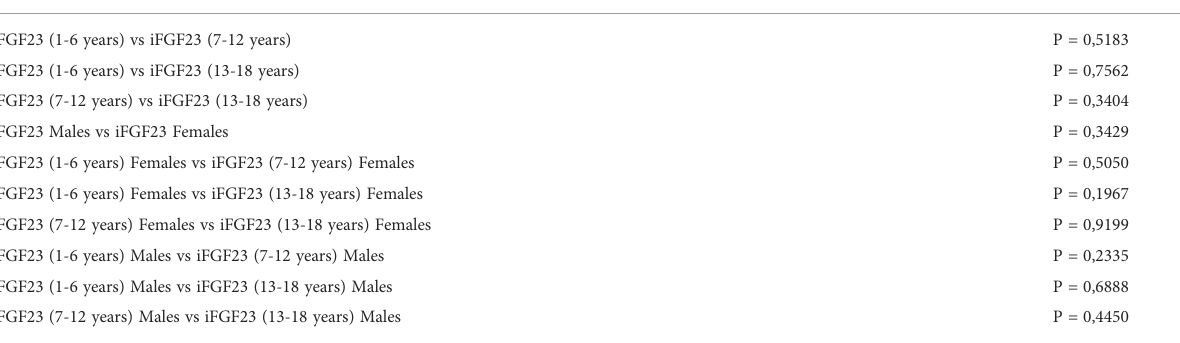
TABLE 5 Comparison of the difference between the medians in the groups of subjects strati fi ed by age and sex (Mann-Whitney test).